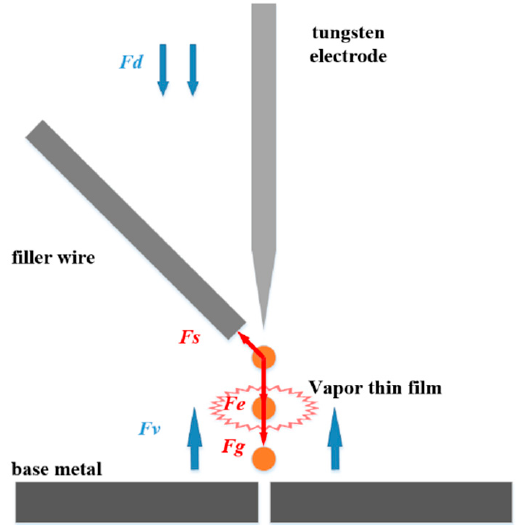
Figure 2. Force analysis diagram of the molten droplet. In the formula above, F g is the gravitational force, which is generated by the density of the wire material ( ρ ), acceleration of gravity ( g ), volume ( V ), and mass of the droplet ( m ).